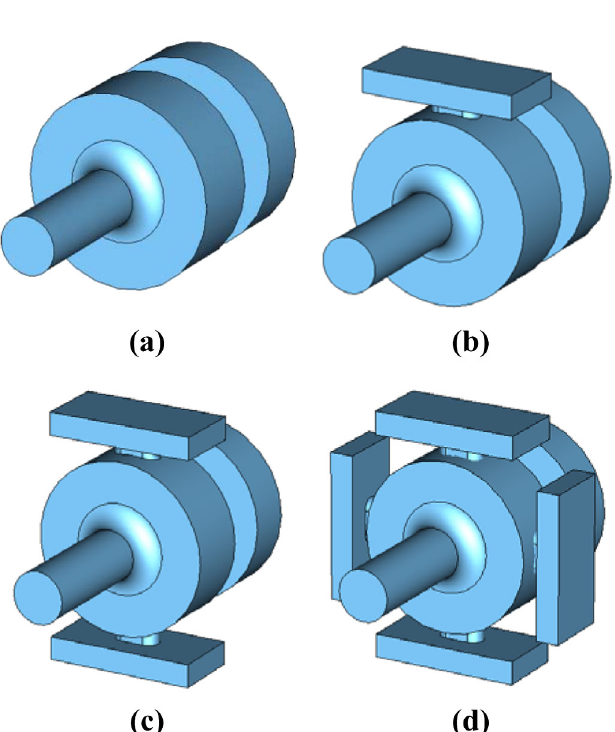
FIG. 1. Simulation models of the rf gun with (a) zero hole, (b) one hole, (c) two holes, and (d) four holes in the full cell part.